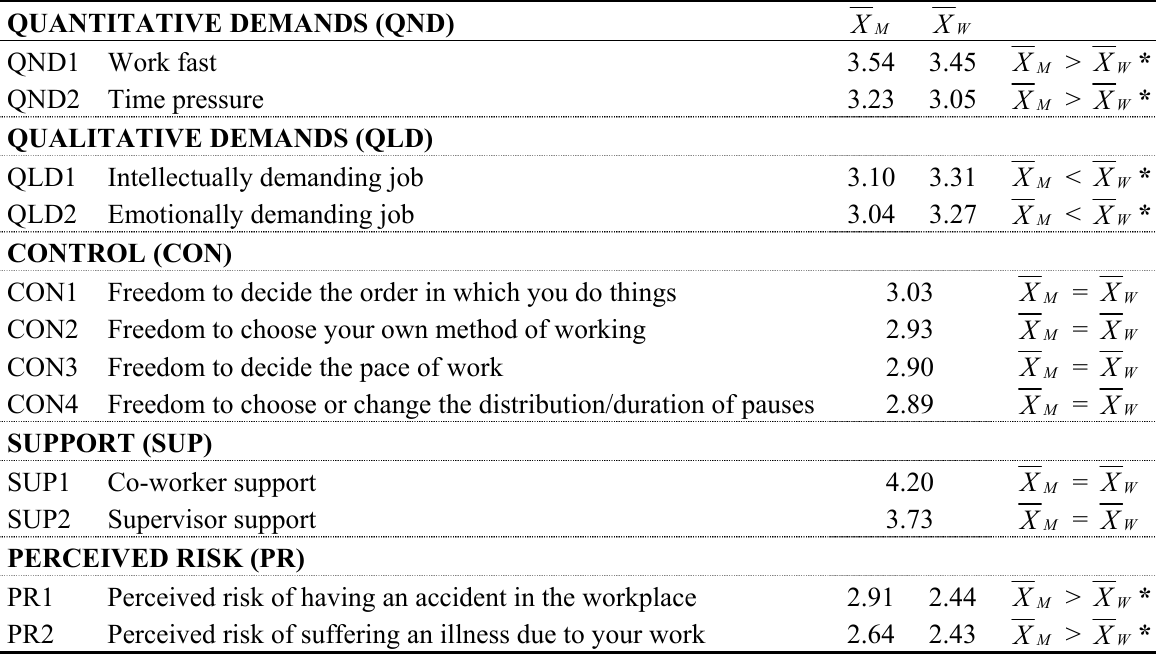
Table 1. Descriptive statistics: mean, by